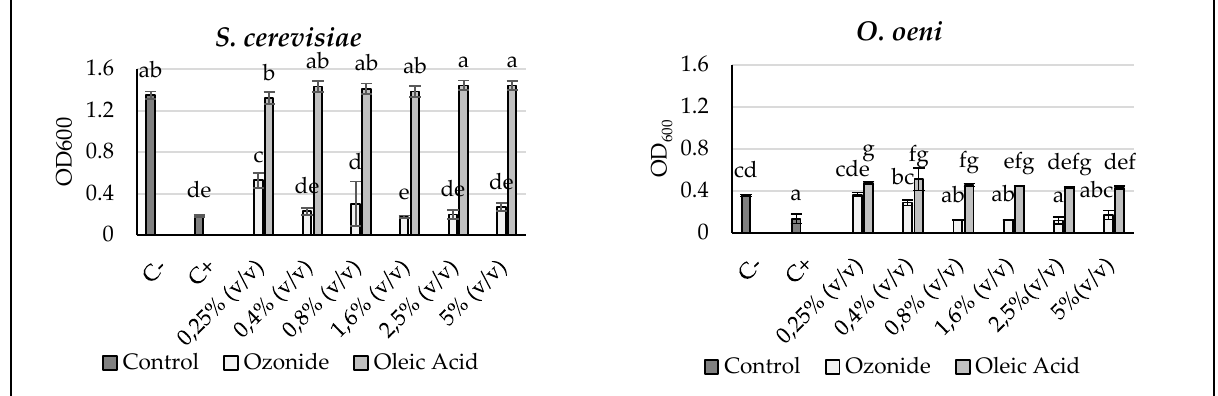
Figure 1. Efficacy of ozonized oleic acid is concentration-dependent and varies between different organisms. The OD 600 of S. cerevisiae liquid cultures one day after inoculation and O. oeni liquid cultures six days after inoculation are depicted as mean values and standard deviations with n ≥ 3. Letters indicate results of ANOVA analysis followed by Fisher’s LSD post-hoc procedure ( left ) and Kruskal–Wallis two-sided non-parametric test, followed by Conover–Iman post-hoc procedure with Bonferroni adjustment for multiple pairwise comparisons ( right ) with p < 0.05.